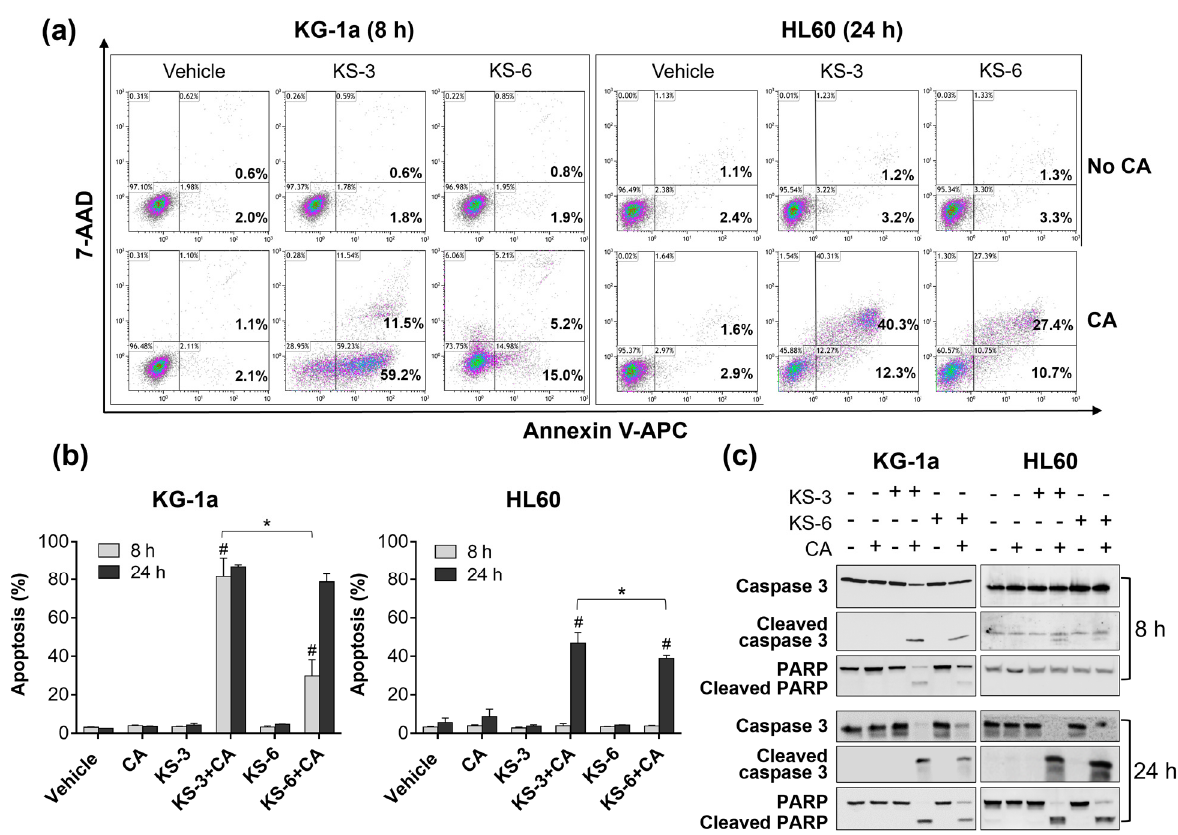
Figure 4. Comparison between the apoptosis-inducing effects of the combinations of KS-3 and KS-6 with carnosic acid. KG-1a and HL60 cells were cultured with 5 µ M KS-3 or KS-6, 10 µ M carnosic acid (CA) or their combinations, for 8 or 24 h. The extent of apoptosis was determined by the annexin V/7-AAD binding assay or Western blotting. ( a ) Typical flow cytometric data obtained in representative experiments. ( b ) Averaged percentages of apoptotic (early + late) cells as exemplified in panel ( a ). The data are the means ± SD ( n = 5). *, p < 0.05, significant differences between the indicated groups; Student’s t test. #, p < 0.05, effect of a combination vs. sum of the effects of single agents; Student’s t test. ( c ) Caspase-3 and PARP cleavage in KG-1a and HL60 cells following treatment with KS-3 or KS-6, alone or together with